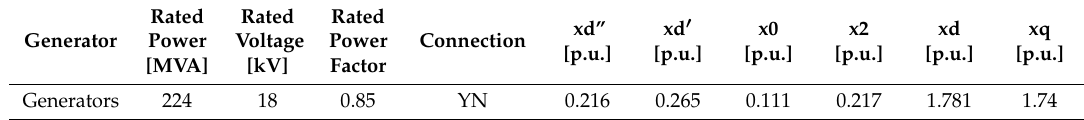
Table A5. Electrical parameters for the generators used in the sample power system.